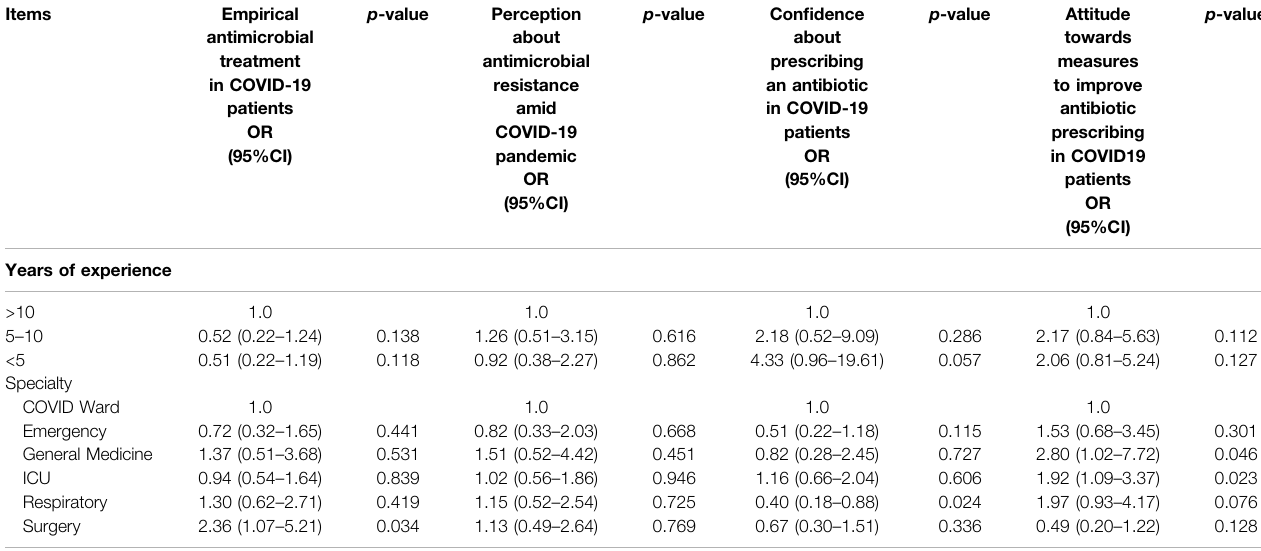
TABLE 4 | Logistic regression examining the association of years of experience and specialty with physicians ’ perception, attitudes, and con fi dence about antimicrobials. Items